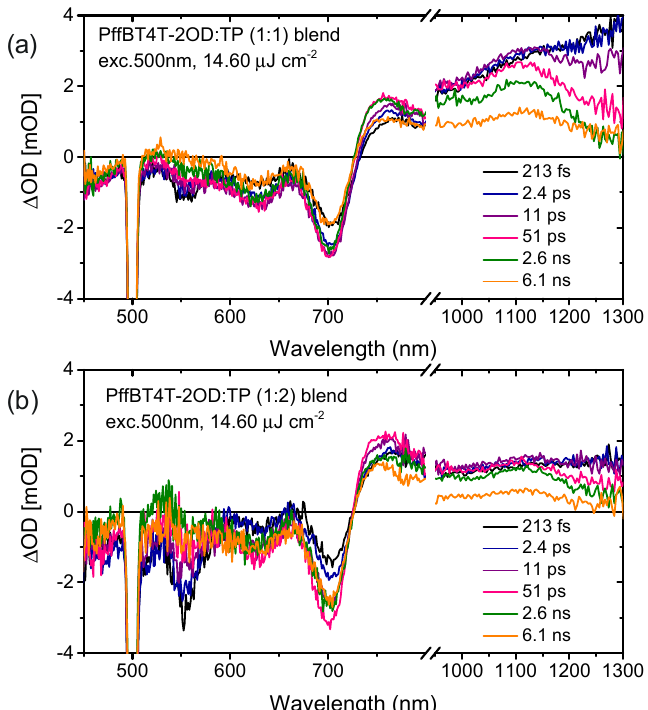
Figure 3. fs-Transient absorption spectra of blends of PffBT4T-2OD:TP of ( a ) 1:1 and ( b ) 1:2 weight ratio excited at 500 nm.